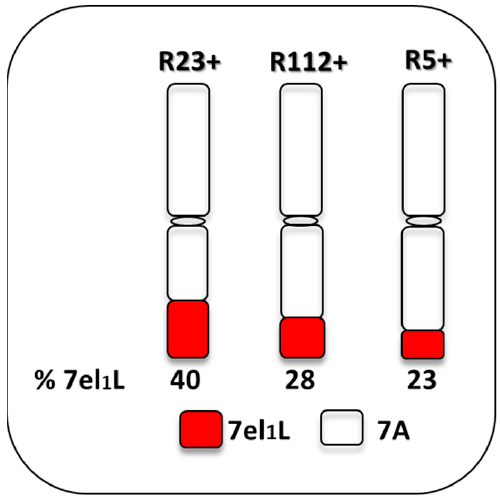
Figure 1. Durum wheat- Thinopyrum ponticum recombinant lines tested under heat and water-deficit conditions. 7el 1 L: chromosome segment derived from Th. ponticum and transferred via a chromosome engineering strategy; 7A: durum wheat recipient chromosome.